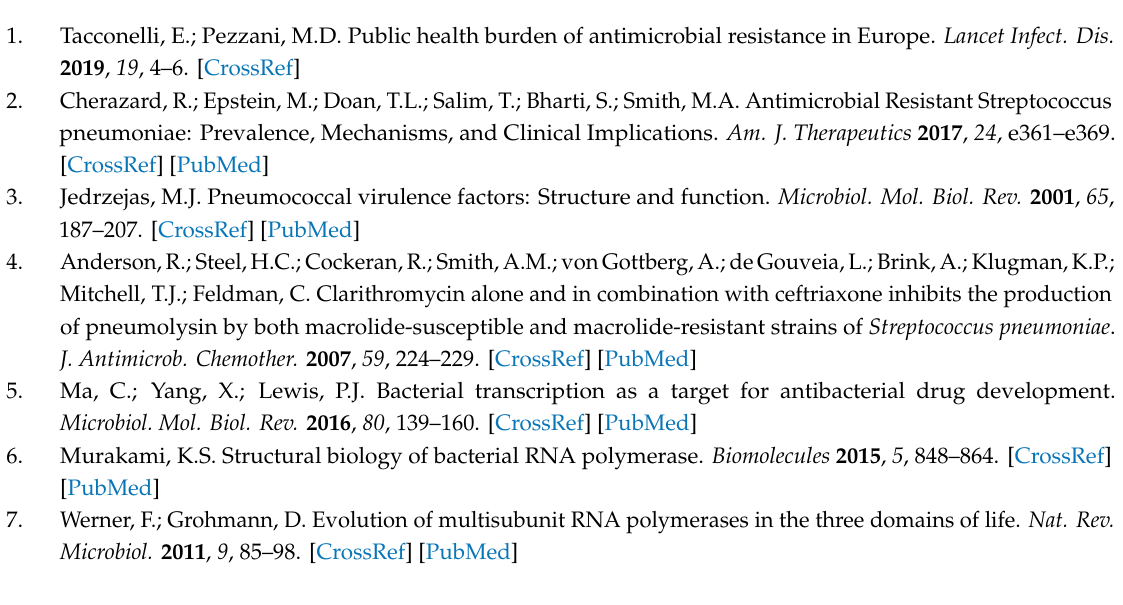
Supplementary Materials: Figure S1: IC 50 measurement of C3 against the protein-protein interaction between RNAP CH- σ , Table S1: The luminescence data of C3 inhibiting the RNAP CH– σ protein-protein interaction, 1 H- & 13 C-NMR: C3-001 , C3-002 , C3-003 , C3-004 , C3-005 , and HPLC spectra: C3-001 , C3-002 , C3-003 , C3-004 , C3-005